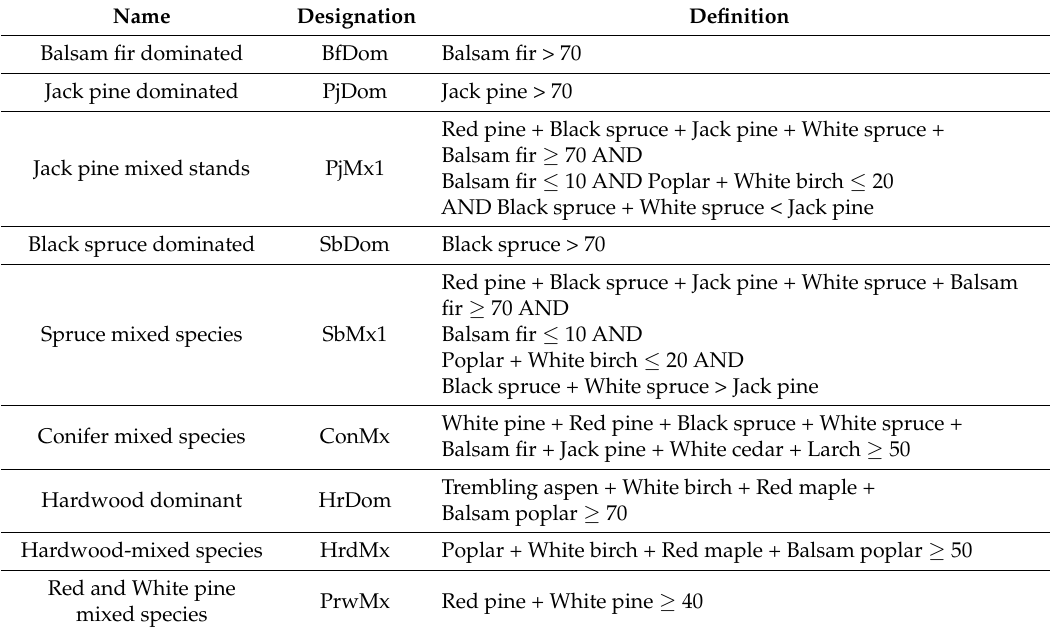
Table 1. Definition of stand types.